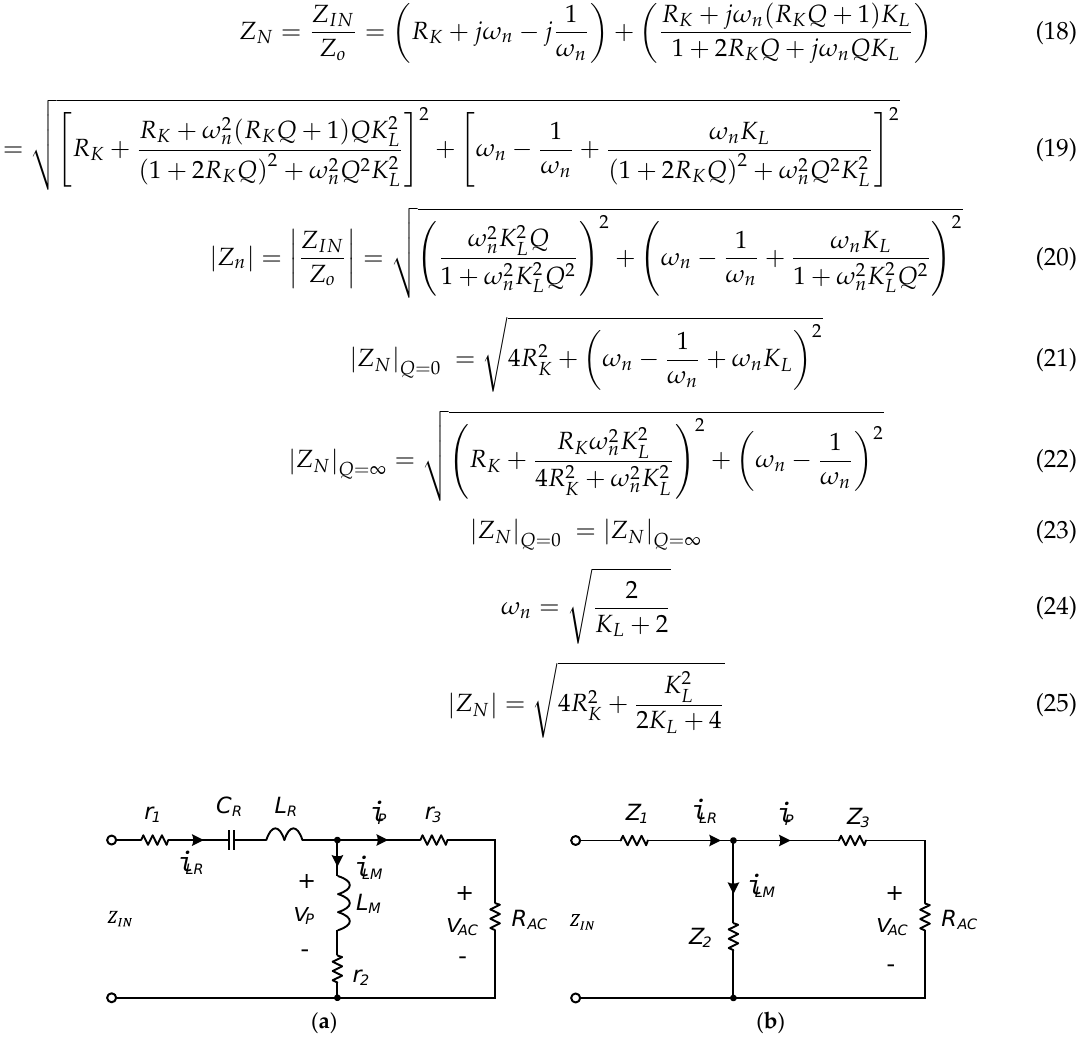
Figure 9. The input impedance 𝑍 𝑁 of the AC equivalent circuits: ( a ) Equivalent circuit of input impedance 𝑍 𝑁 ; and ( b ) simplified equivalent circuit of input impedance 𝑍 𝑁 .